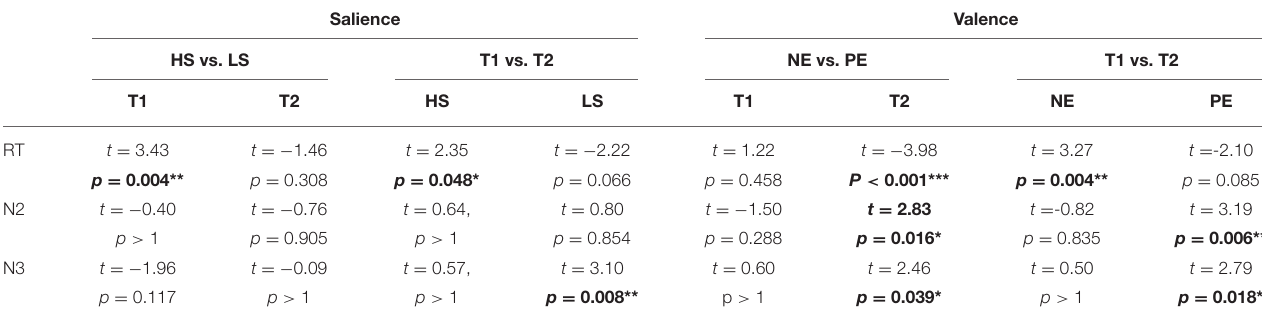
TABLE 1 | Paired t -test for the salience (high HS and low LS) and valence (negative NE and positive PE) effect on reaction time and ERP amplitudes in the AMST for placebo condition. Salience